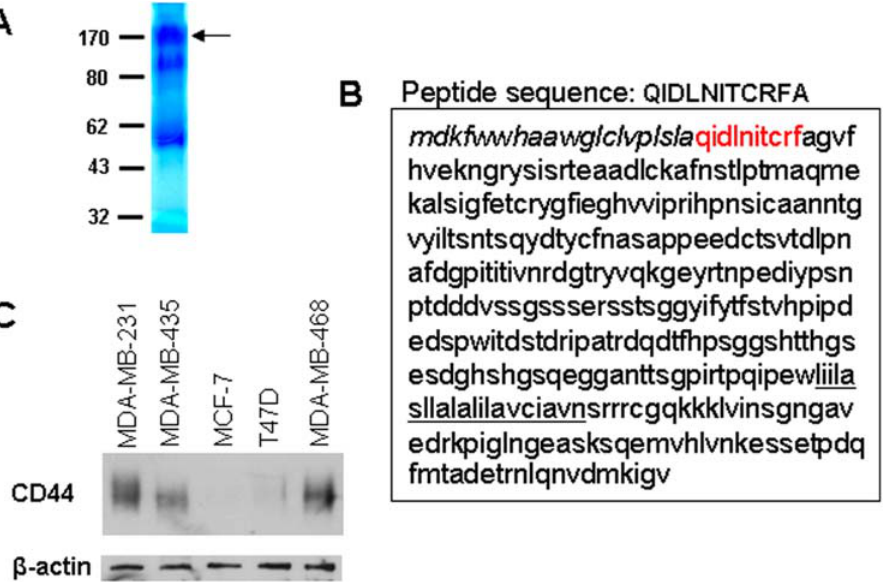
Figure 4. Identification of the major E-selectin binding protein in metastatic breast cancer cells as human CD44. A: Gel-code staining of proteins eluted from an exE-selectin/Fc affinity column. A 170 kD protein indicated by the arrow was selected as a potential ligand of E-selectin in tumor cells since 130 kD and 50 kD protein bands were confirmed as exE-selectin/Fc and IgG heavy chain, respectively. B: matching of the 10 amino acid N-terminal peptide sequence (red) of the 170 kD purified protein with that of human CD44. C: Western blot analysis of five breast cancer cell lines with anti-CD44H antibody.